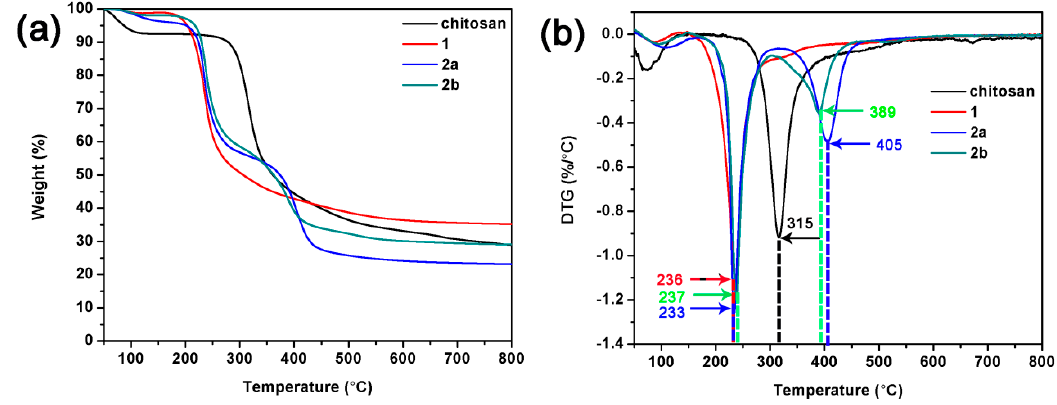
Figure 4. TGA ( a ) and DTG ( b ) curves of chitosan and chitosan derivatives.